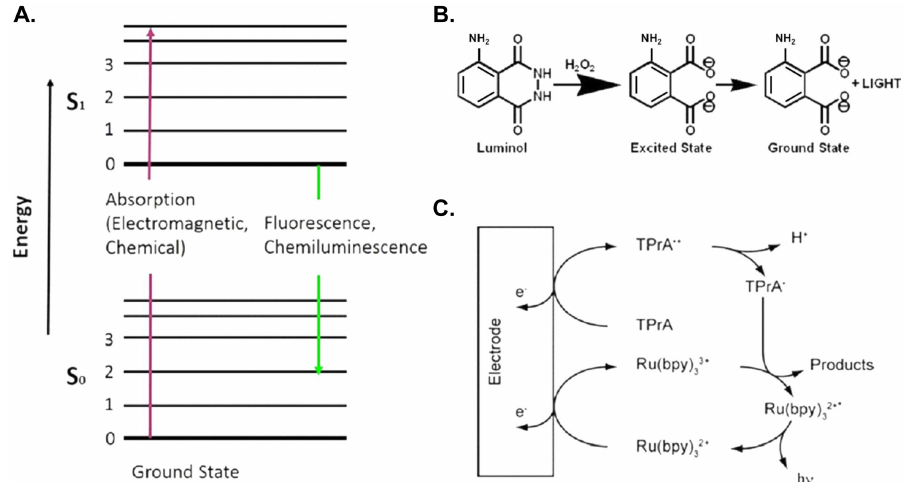
Figure 2. Mechanisms of luminescence. ( A ) Absorption of electromagnetic radiation, photoluminescence and chemiluminescence; ( B ) chemiluminescence; ( C ) electrochemiluminescence. Figure 2B is reproduced with permission from the Chemical Connection website [63].